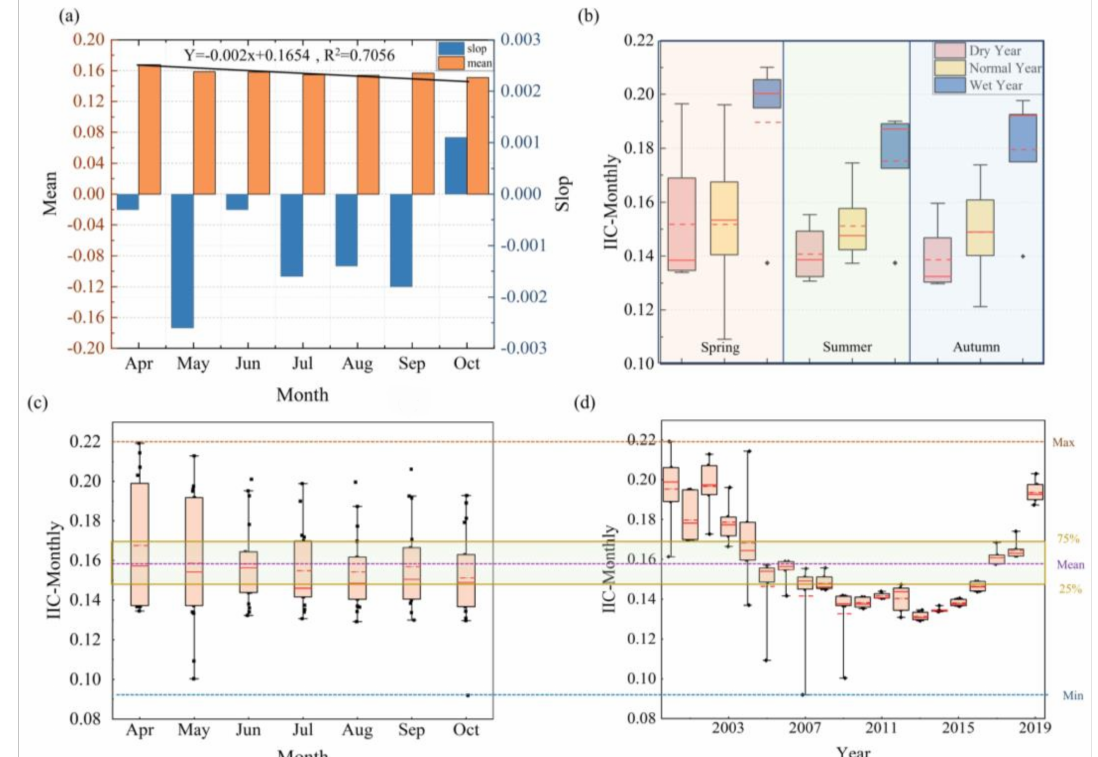
Figure 4. ( a ) Distribution of monthly-IIC; ( b ) Monthly-IIC under different seasons for different year types; ( c ) Box plot of monthly-IIC distribution from April to October in 2000 to 2019; ( d ) Monthly-IIC Distribution boxplots from April to October in 2000 to 2019. The meaning of the boxes and lines are the same with Figure